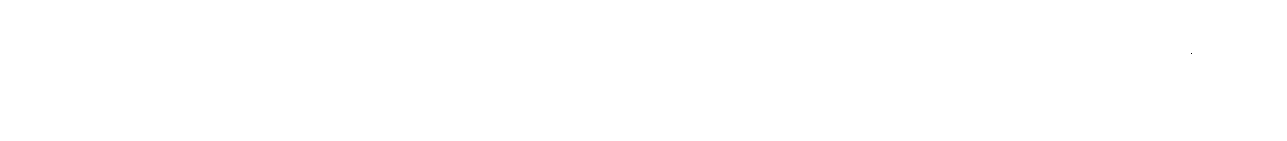
Tabelle en Figure moet op afsonderlike bladsye verskyn (een bladsy per tabel/illustrasie). Figure, grafieke en lyntekeninge moet